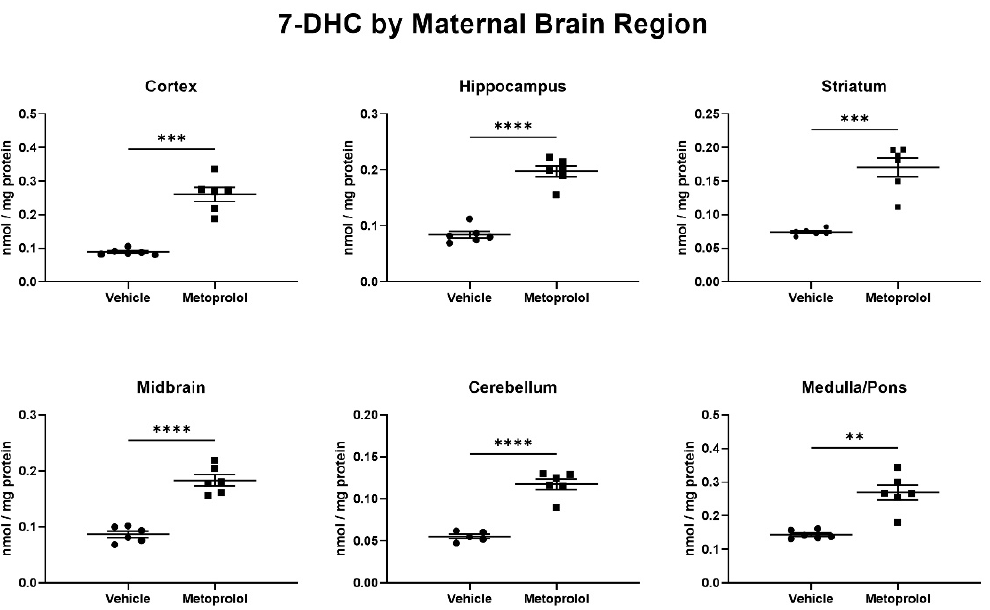
Figure 4. Metoprolol elevates 7-DHC throughout the maternal brain. Pregnant mice were treated with 35 mg/kg MTP from E12 to E19. Dam brains were analyzed for sterol content by LC-MS/MS. Statistical significance: ** p < 0.01; *** p < 0.001; **** p < 0.0001 vs. vehicle treatment. Note that 7-DHC baseline levels in the vehicle-treated animals are different across the brain regions, and that a robust 7-DHC elevation is evident in all investigated brain regions. In the same brain regions, cholesterol levels were unchanged (Figure S9).